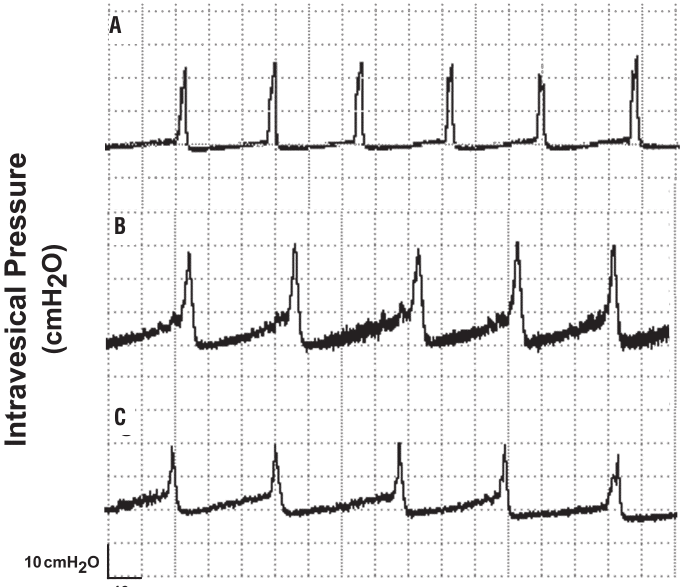
Figure 2 – Cystometric recordings of a female Wistar rat which underwent bladder autotransplant performed 30 days before. The rats were anesthetized with urethane for evaluation of the maximal pressure amplitude of the neobladder (A), micturition interval (B) and micturition duration (C). There was flow rate of bladder perfusion (0.9% saline solution, at 37 ºC) was 0.08